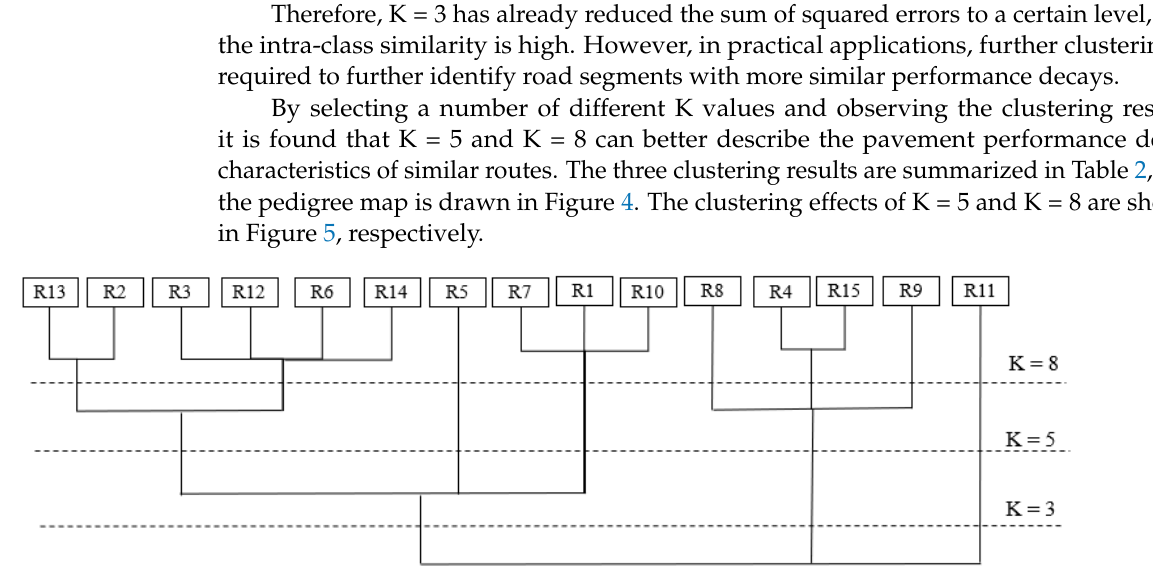
Figure 4. The clustering pedigree obtained by using the K-means algorithm based on the road segment pavement performance distribution.